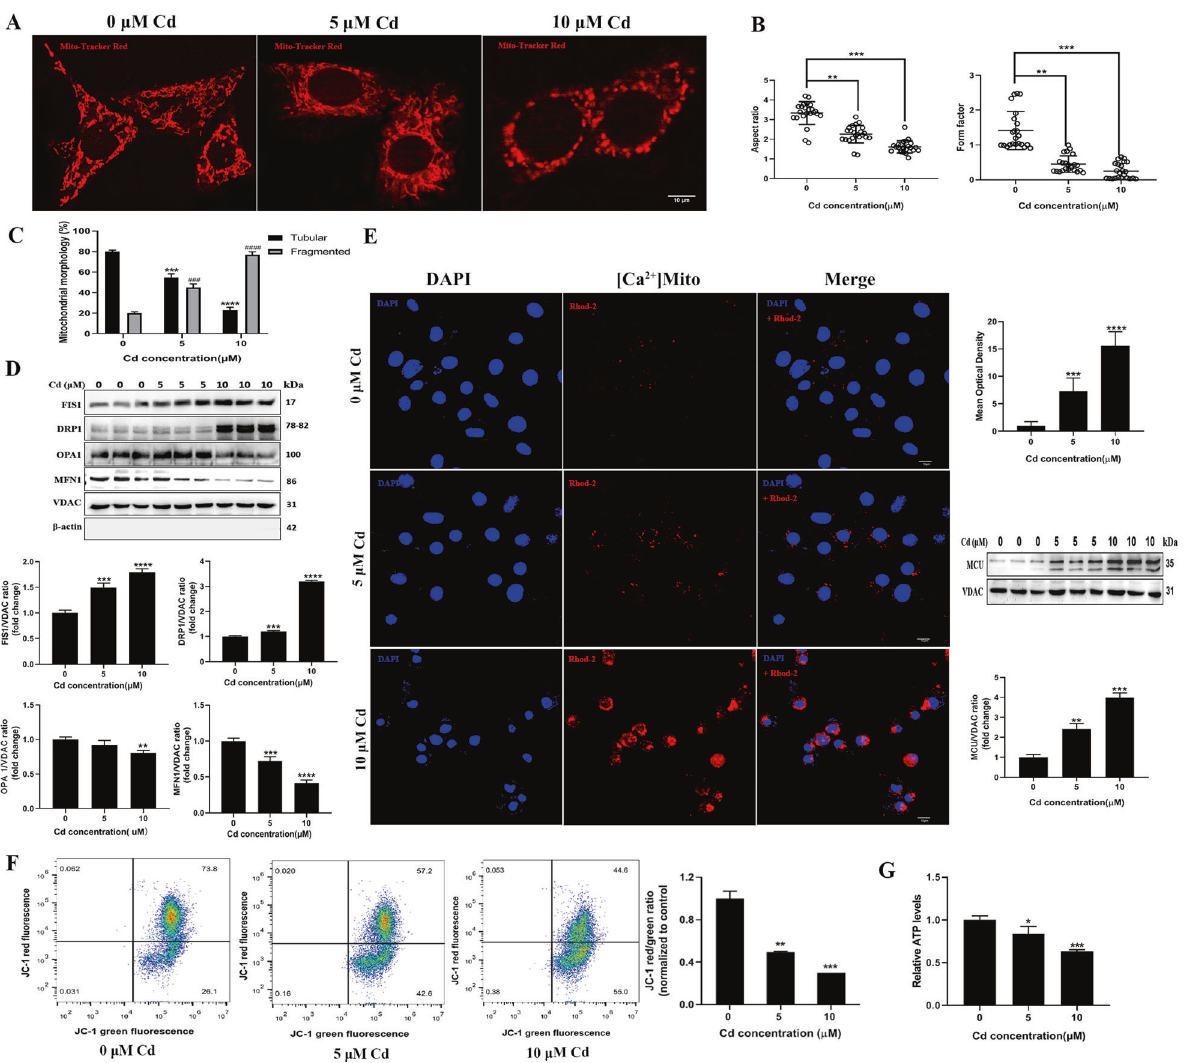
C The percentage of cells containing tubular or fragmented mitochondria was calculated. D The protein levels of FIS1, DRP1, OPA1 and MFN1 were measured by Western blot after treatment with cadmium. E The effects of cadmium on mitochondrial Ca 2 + levels and expression of mitochondrial calcium uniporter (MCU) were analyzed by immuno fl uorescence and Western blot, respectively. F The effect of cadmium on mitochondrial ΔΨ m was assayed by JC-1 staining. G Luciferase-based assays were used to determine cellular ATP production. The data represent the mean ± SD of three independent experiments (* P < 0.05, ** P < 0.01, *** P < 0.001, ### P < 0.001, ****> P < 0.0001, #### P < 0.0001 vs.